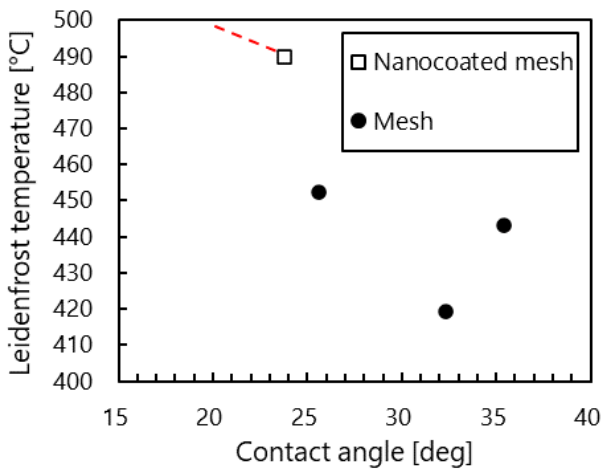
Figure 14. Relationship between contact angle and the